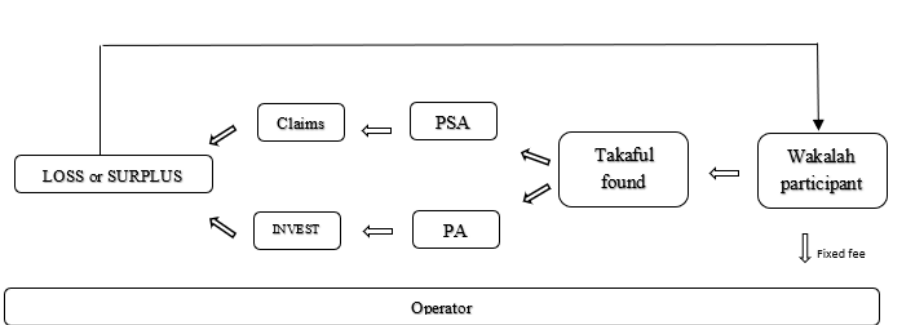
Figure 5. Takaful Wakalah Model